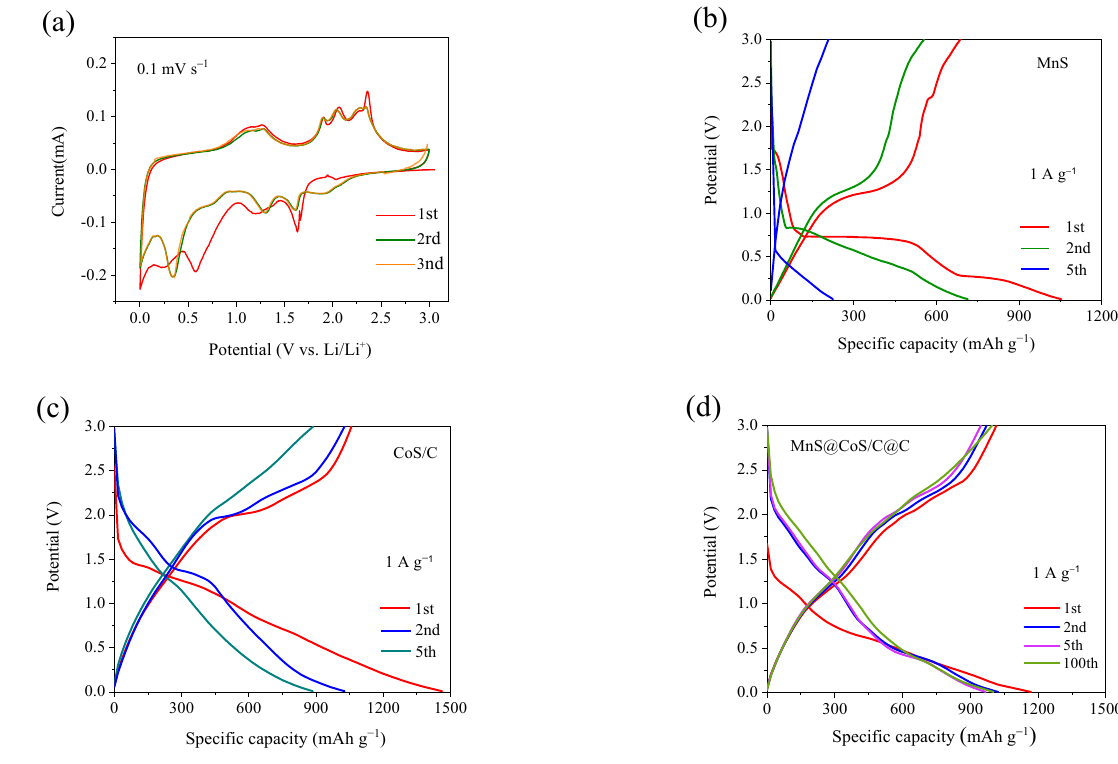
Figure 5. ( a ) CV curves of MnS@CoS/C@C at the scan rate of 0.1 mV s − 1 in the first three cycles, Galvanostatic charge–discharge curves of ( b ) MnS, ( c ) CoS/C, ( d ) MnS@CoS/C@C at current density of 1 A g − 1 .